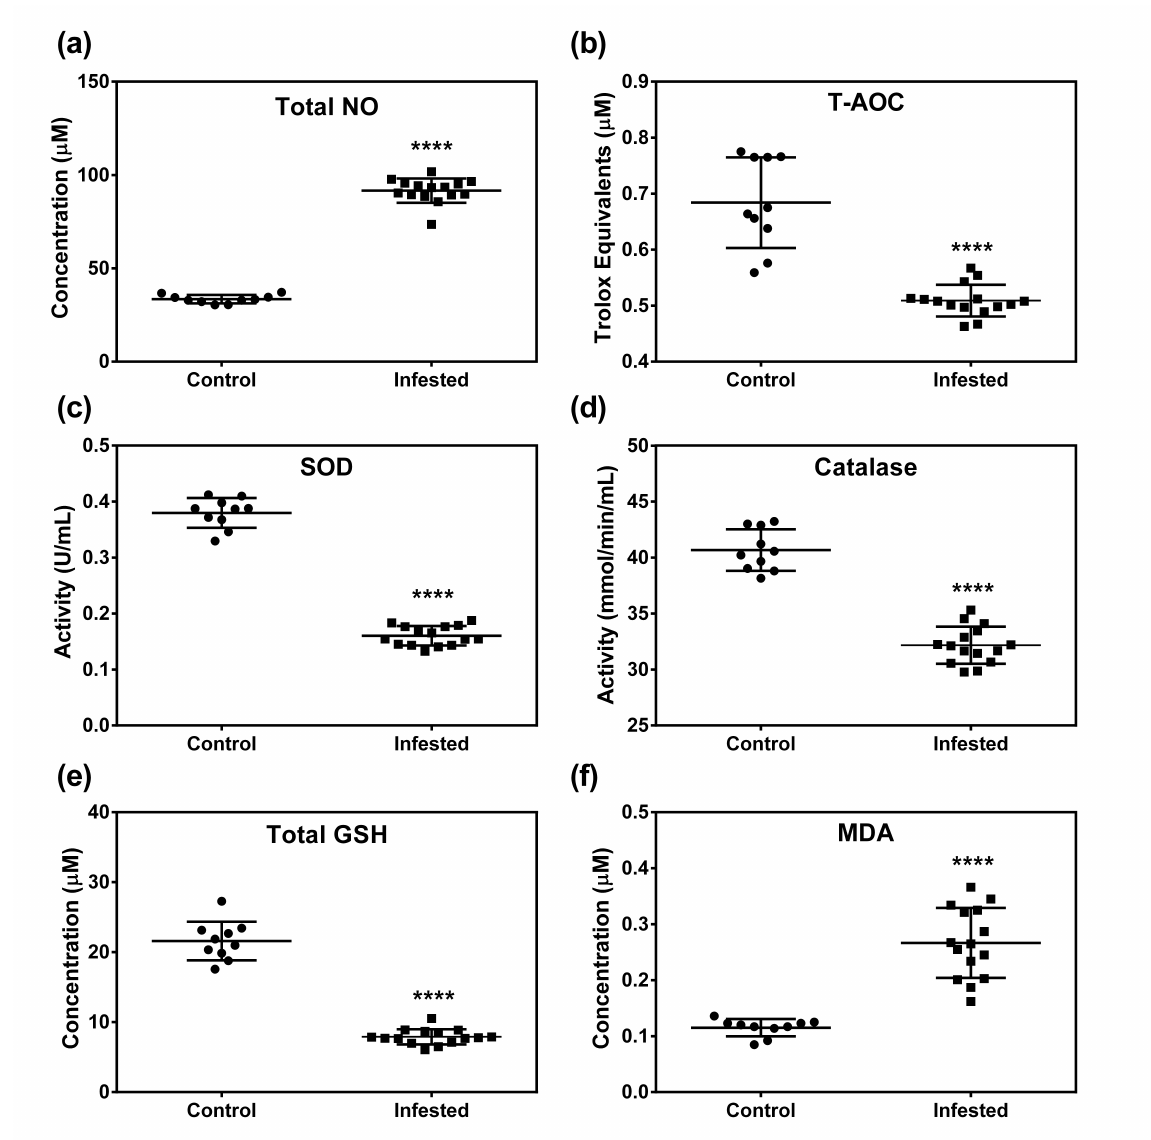
Figure5. E ff ectofcrustedscabiesonantioxidantprofilesandoxidativestressindicatorinaporcinemodel. ( a ) Total nitric oxide (NO) concentration, ( b ) total antioxidant capacity (T-AOC), ( c ) superoxide dismutase (SOD) activity, ( d ) catalase activity, ( e ) glutathione-S-transferase (GSH) concentration, ( f ) malonyldialdehyde (MDA) concentration. Data in scatter plot are shown as mean ± SD. t -test was performed to find out significant di ff erence between the two groups. **** denotes p ≤